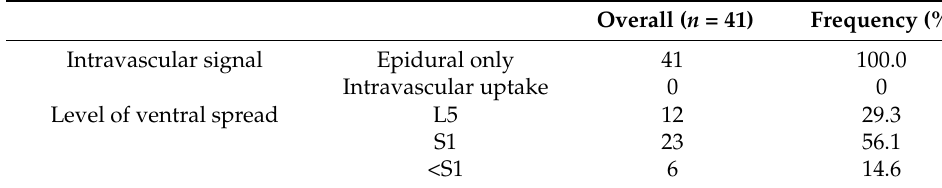
Table 2. Observational data of 41 cases.